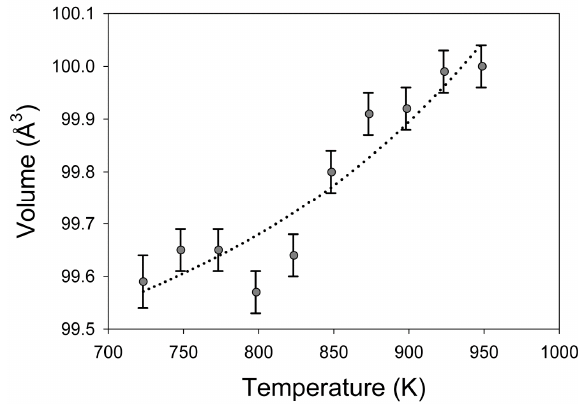
Figure 7. Measured unit cell volumes for tetragonal γ -LaOF as a function of temperature from 723 K to 948 K. The dotted black line is the fit for the Fei thermal equation of state [40].